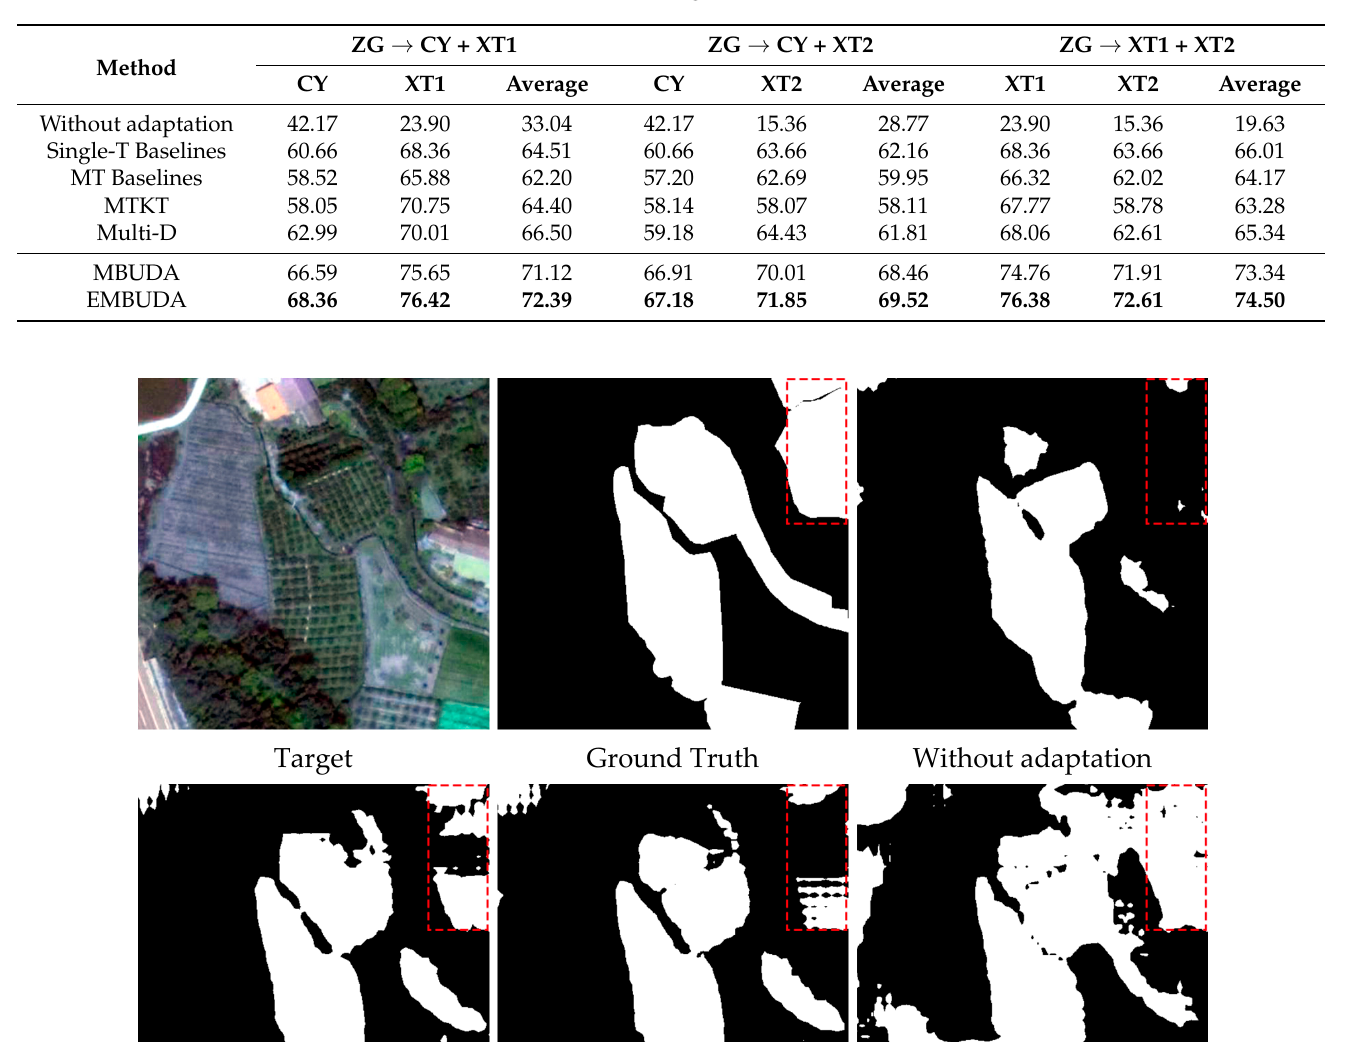
Table 3. The IoU of orchard area segmentation when Dataset ZG is set as the source domain.